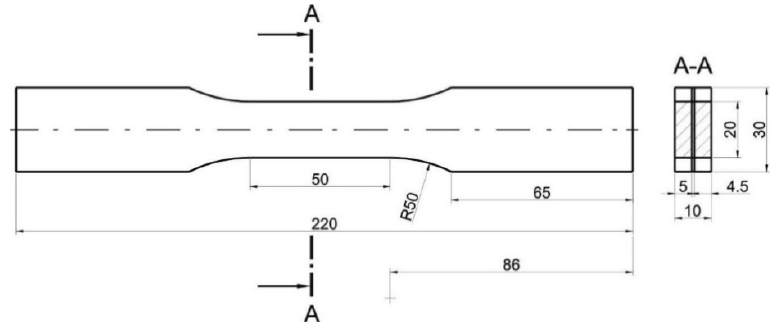
Figure 5. Samples subjected to a static tensile test made of the AA2519-AA1050-Ti6Al4V laminate.